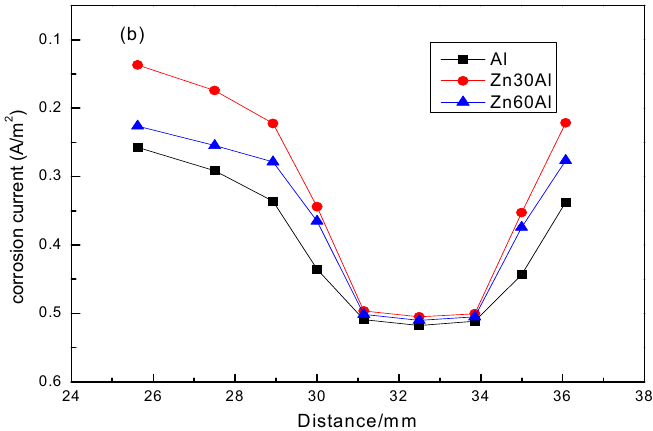
Figure 11. The corrosion current density distribution on the different cold ‐ sprayed AlZn coatings with different damaged areas after 2 h immersion along the sample: ( a ) AlZn coatings with 1 mm damaged area; ( b ) AlZn coatings with 10 mm damaged area.